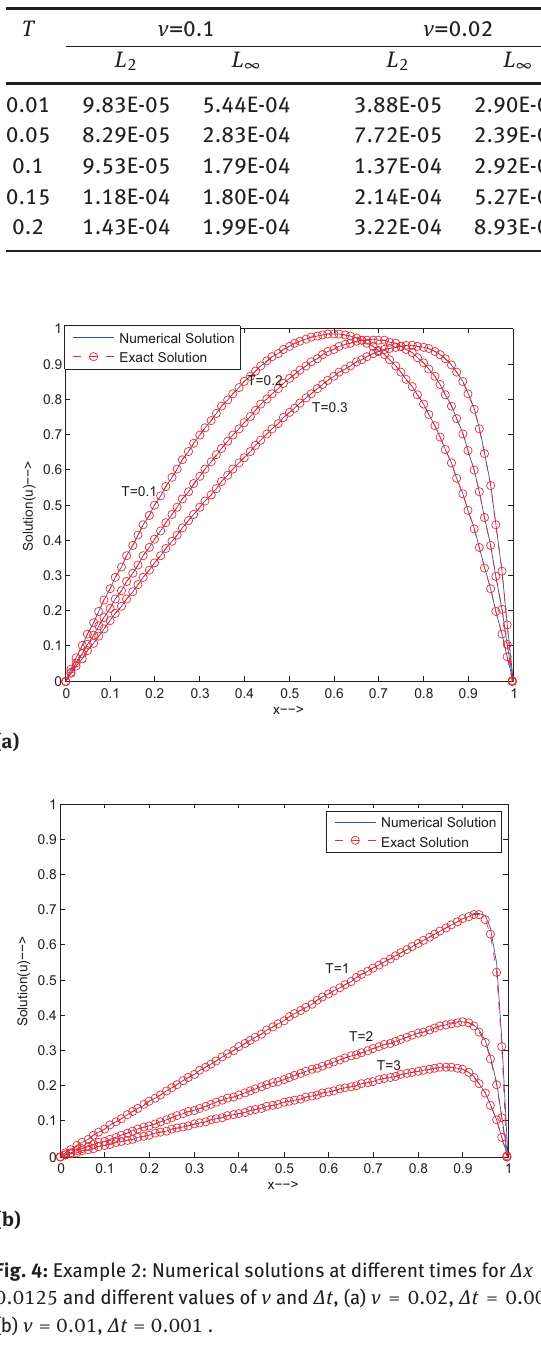
Table 10: Comparison of Errors in L 2 norm and L ∞ norm with Δt = 0.001 for different values of ν , corresponding to Example 2.